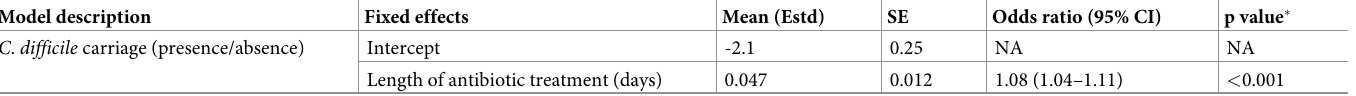
Table 2. Results from the final selected multivariable general linear model to explain carriage of C . difficile by dogs. Model